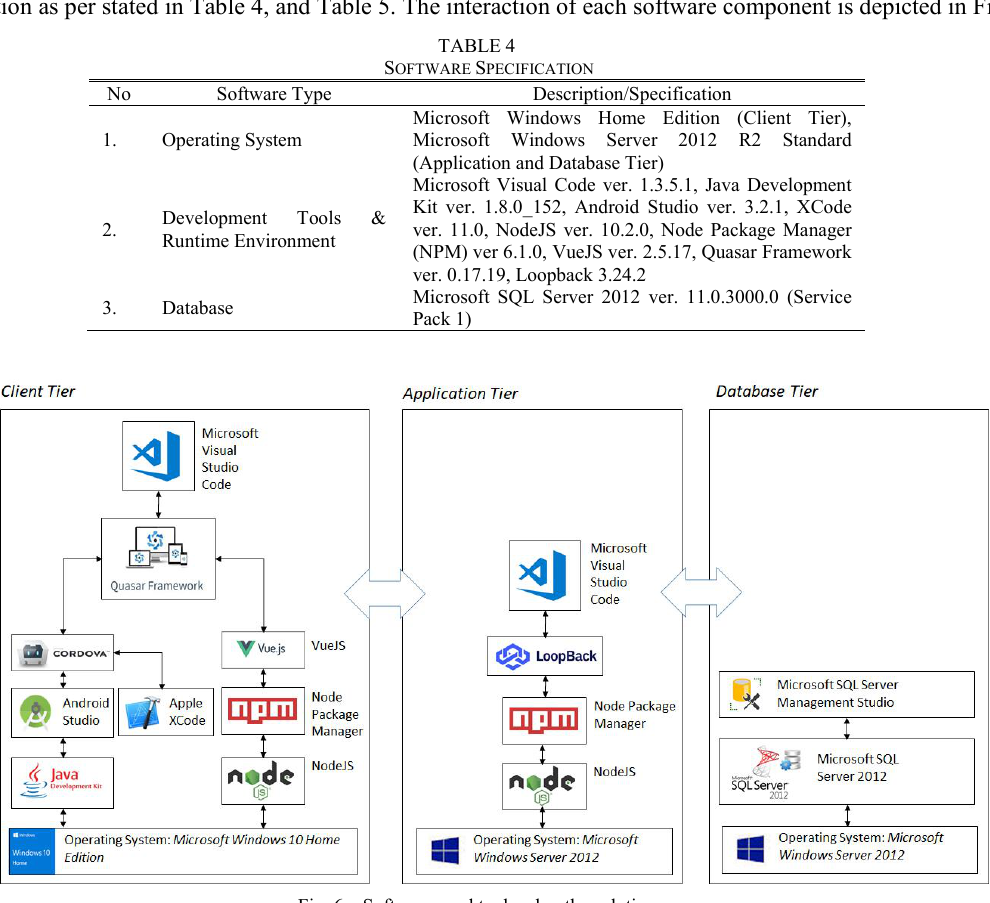
Fig. 6. Software used to develop the